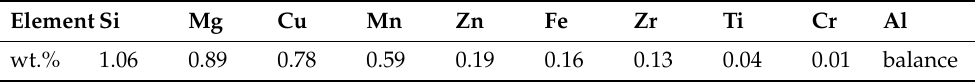
Table 1. Chemical composition of the 6056 aluminum alloy wire (AlSi1MgCuMn). Element Si